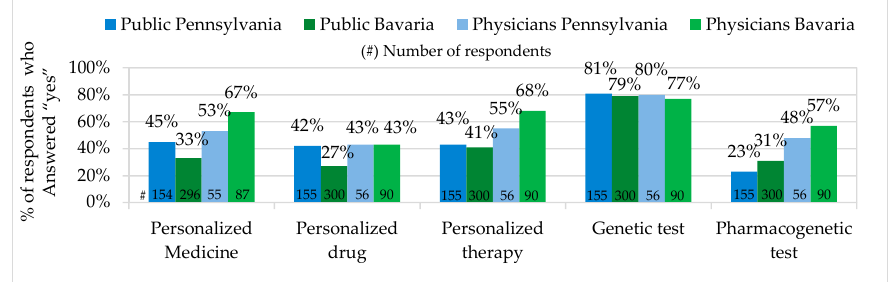
Figure 1. Personalized Medicine Awareness.